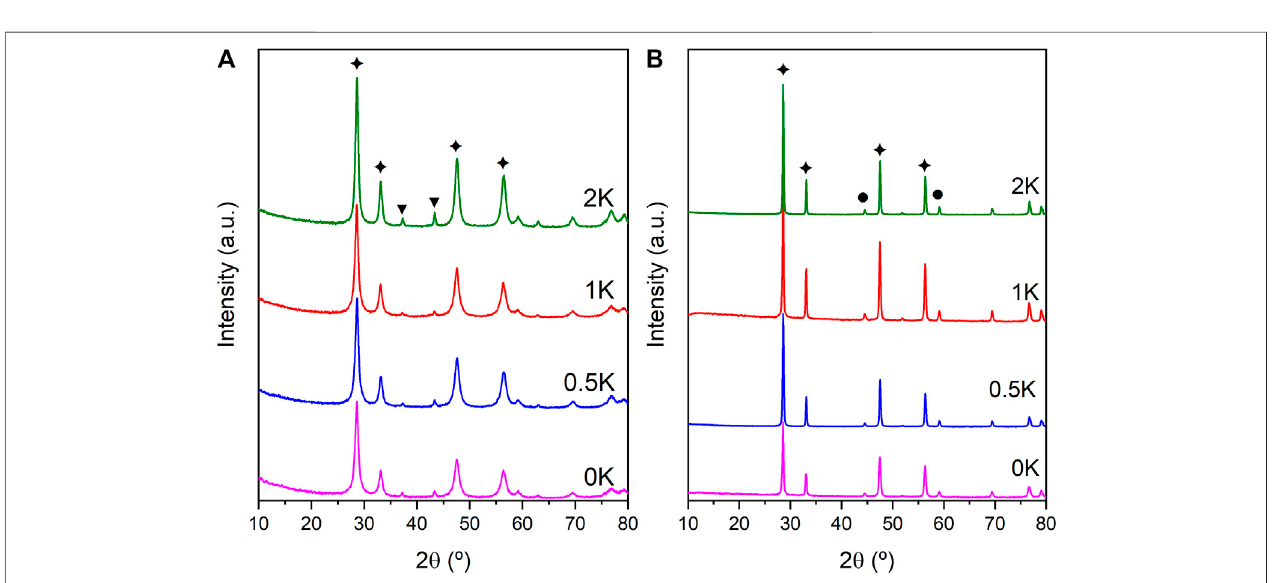
FIGURE 2 | XRD patterns of the (A) non-reduced catalysts and (B) reduced catalysts. ( ✦ CeO 2 JDPS 34-0,394, C Ni JDPS 04-0,850, ▼ NiO JDPS 47-1,094).